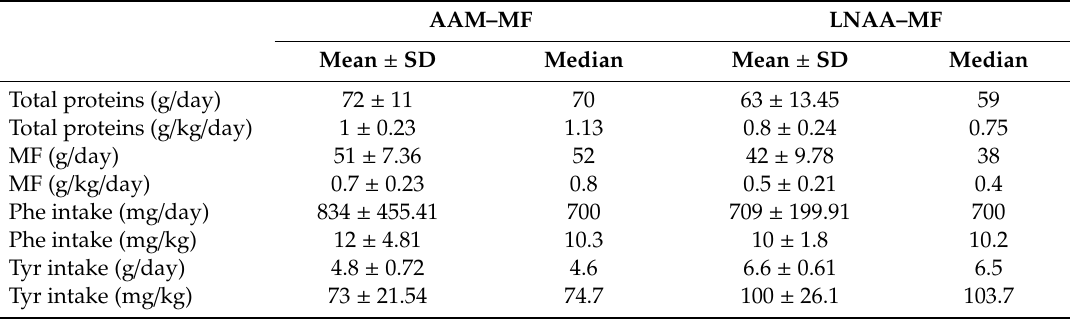
Table 3. Composition of standard amino acid mixtures compared with